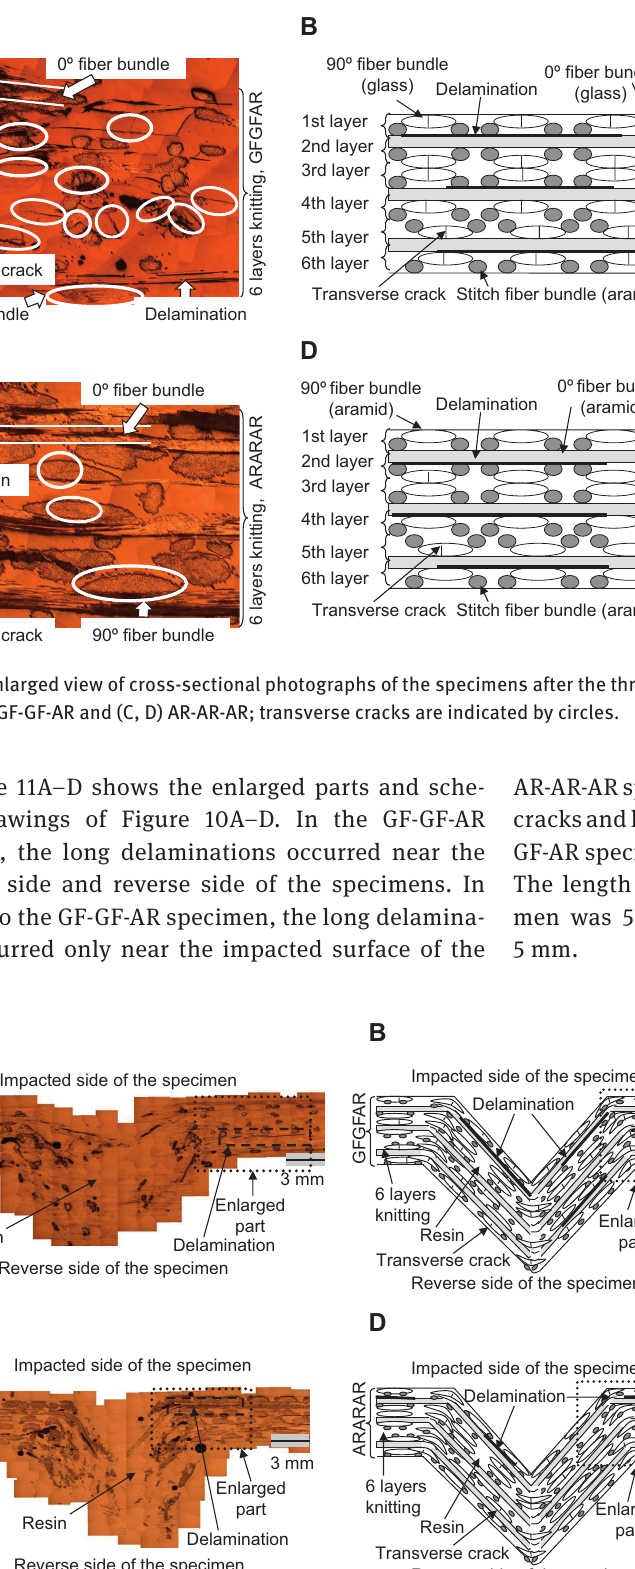
Figure 10 Cross-sectional photographs of the specimens after the plate bending impact test and schematic drawings: (A, B) GF-GF-AR and (C, D) AR-AR-AR.